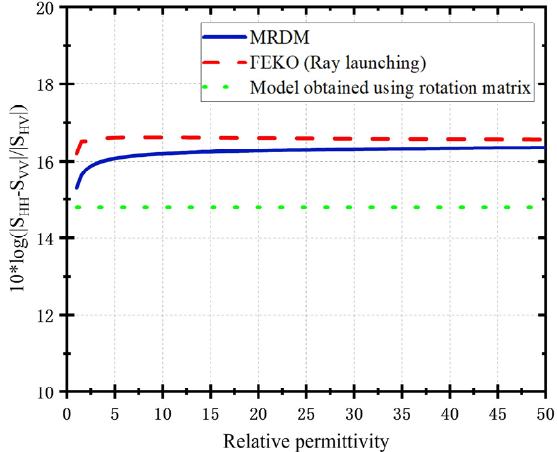
Figure 2. Comparison of parametric scattering model with different relative permittivities.